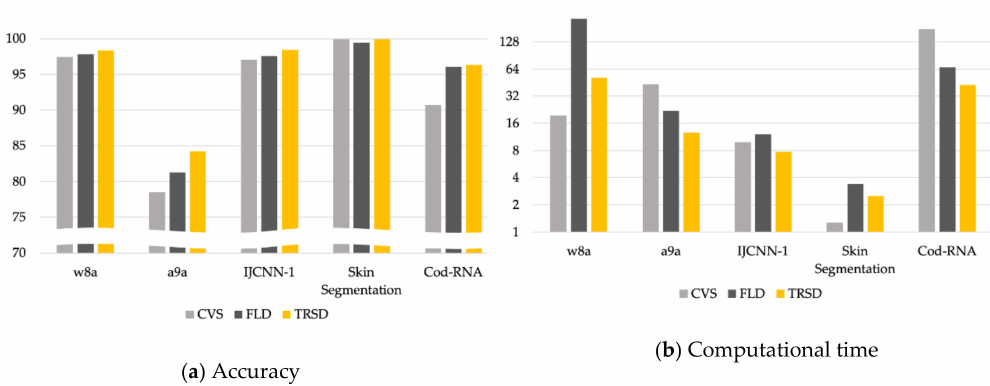
Figure 5. Comparison of the proposed tree-based relative support distance (TRSD) with candidate vectors (CVS) and Fisher linear discriminant analysis (FLD) on the five largest